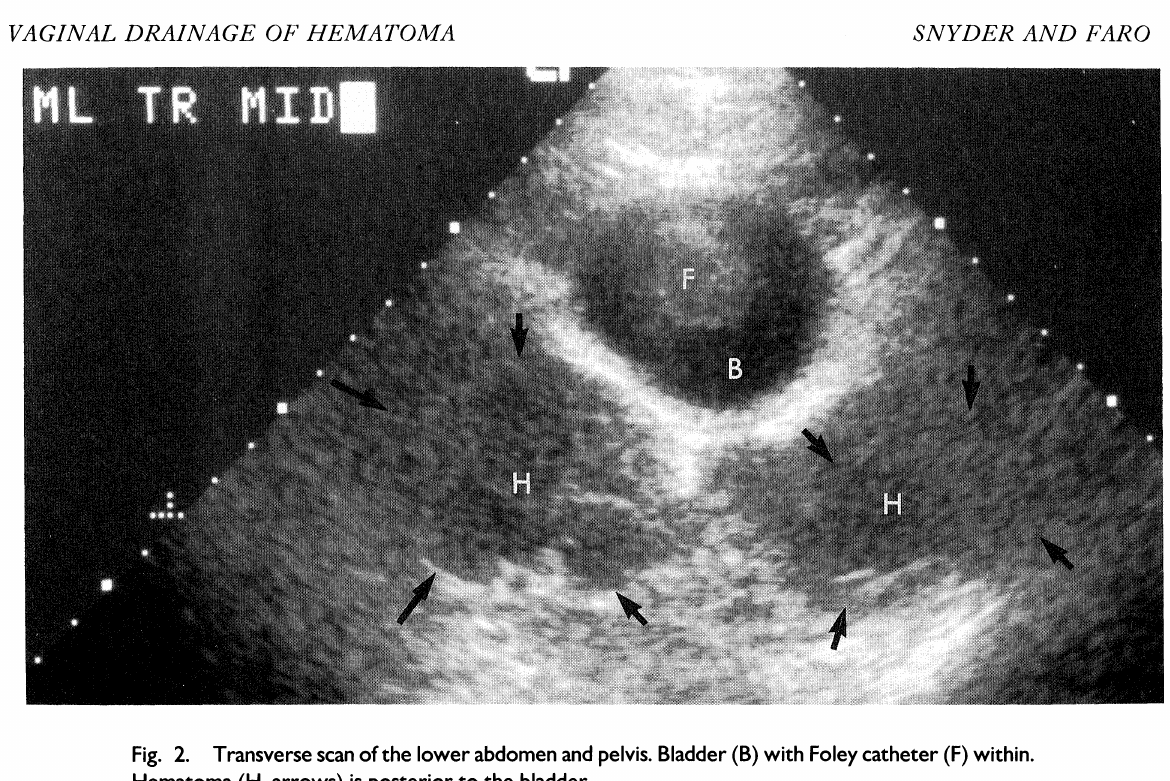
Fig. 2. Transverse scan of the lower abdomen and pelvis. Bladder (B) with Foley catheter (F) within. Hematoma (H, arrows) is posterior to the